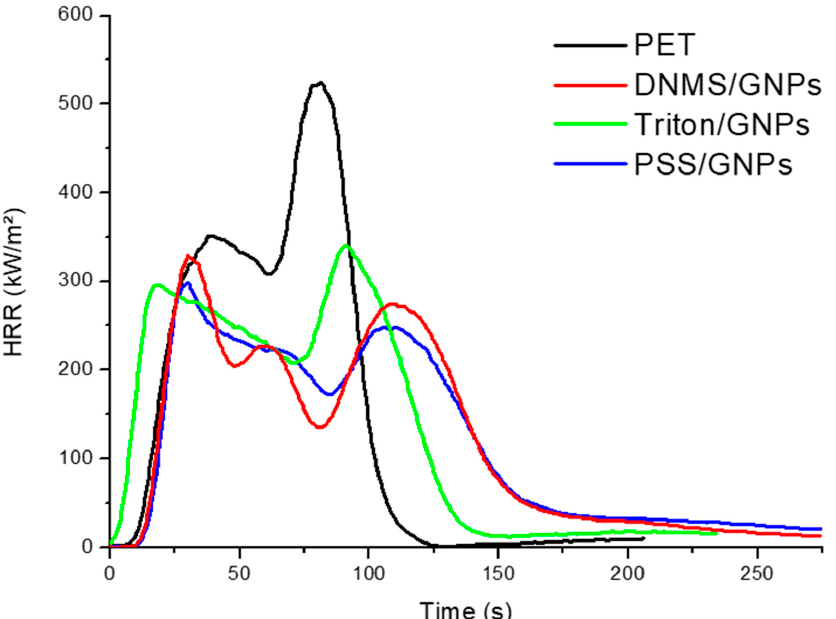
Figure 6. Heat release rate (HRR) vs. time curves for neat PET and coated sample with 2.5 wt% GNPs.